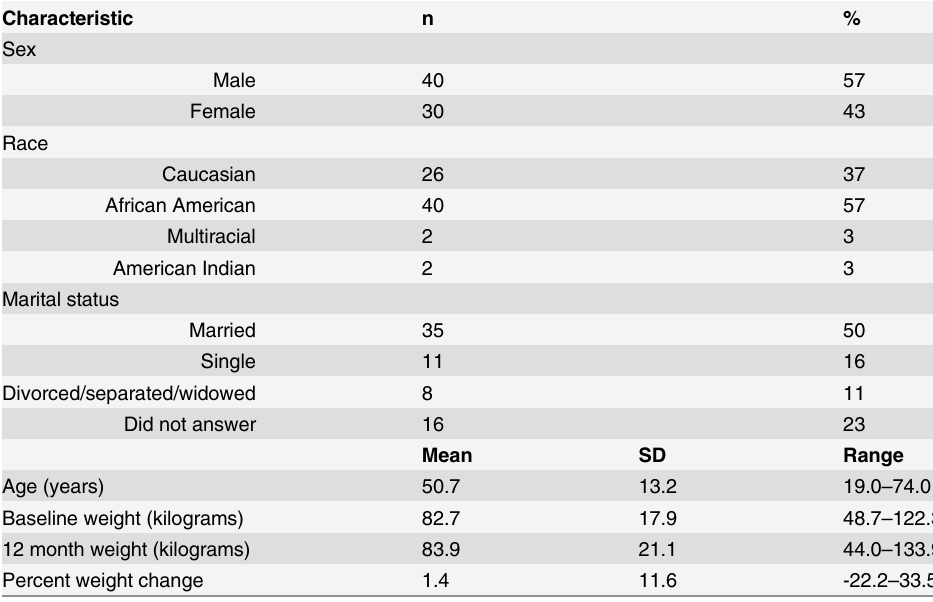
Table 1. Demographics of the study